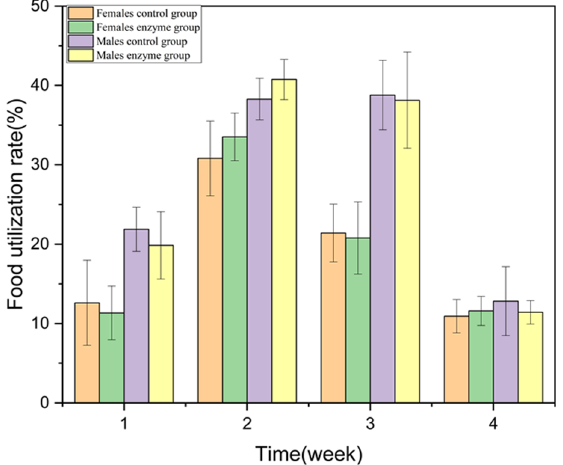
Figure 4. Effect of enzyme solution on food utilization rate of rats.